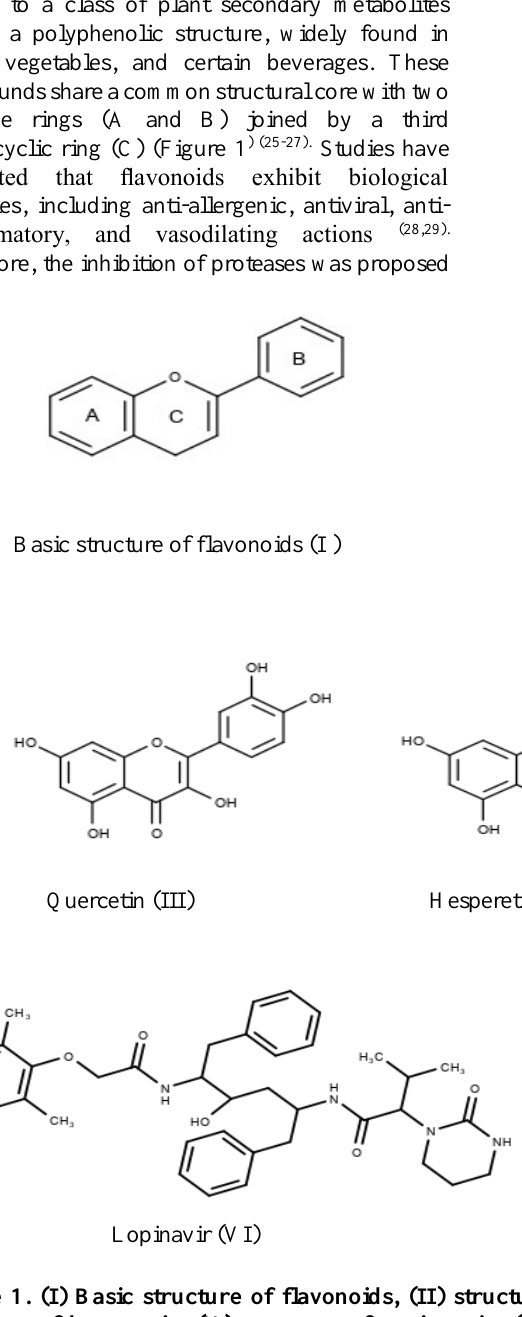
Figure 1. (I) Basic structure of flavonoids, (II) structure of naringin, (III) structure of quercetin, (IV) structure of hesperetin, (V) structure of naringenin, (VI) structure of lopinavir and (VII) structure of